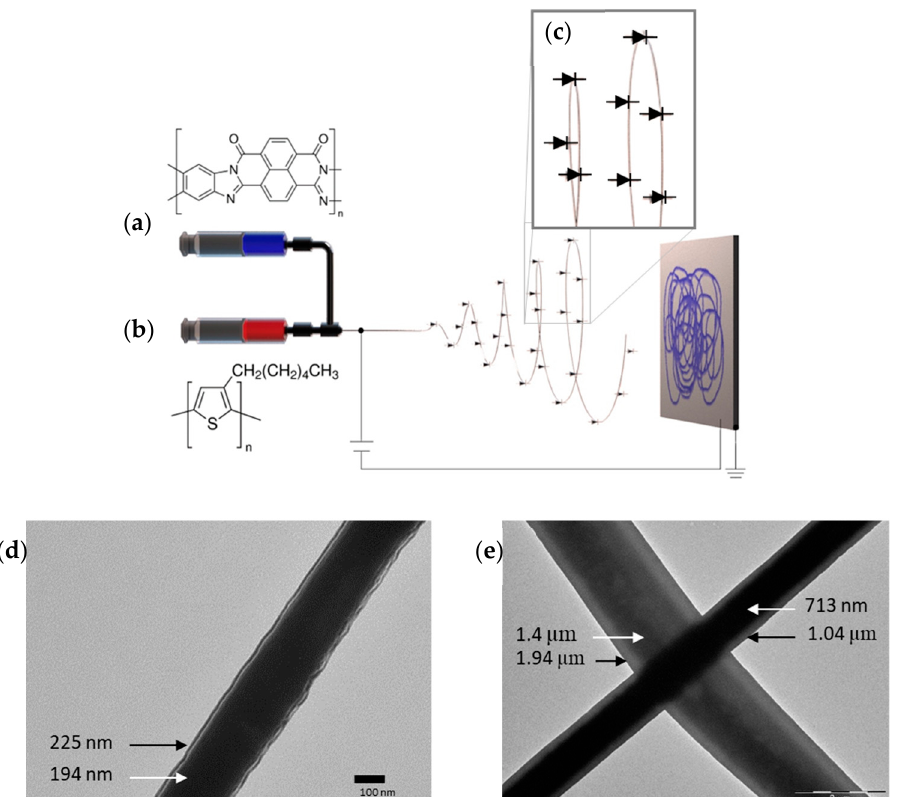
Figure 4. Fabricated electrospun continuous coaxial nanofiber–p-n junctions. The shell/sheath is formed by the BBL solution ( a , blue) and covers the P3HT/PS solution ( b , red) core. An electric field overcomes the surface tension, forming nanofibers. Inset: ( c ) diode symbols representing the continuous heterojunction formed between the core and the shell. ( d , e ) Formed coaxial nanofibers where BBL covers the P3HT/PS core. Adapted with permission from [64].